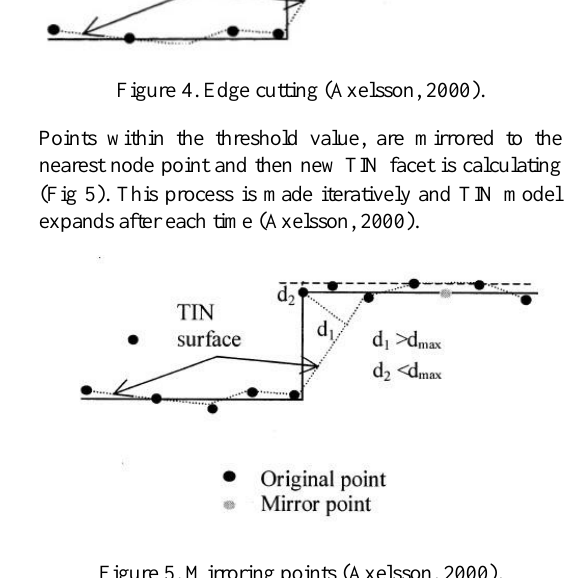
Figure 5. Mirroring points (Axelsson, 2000).